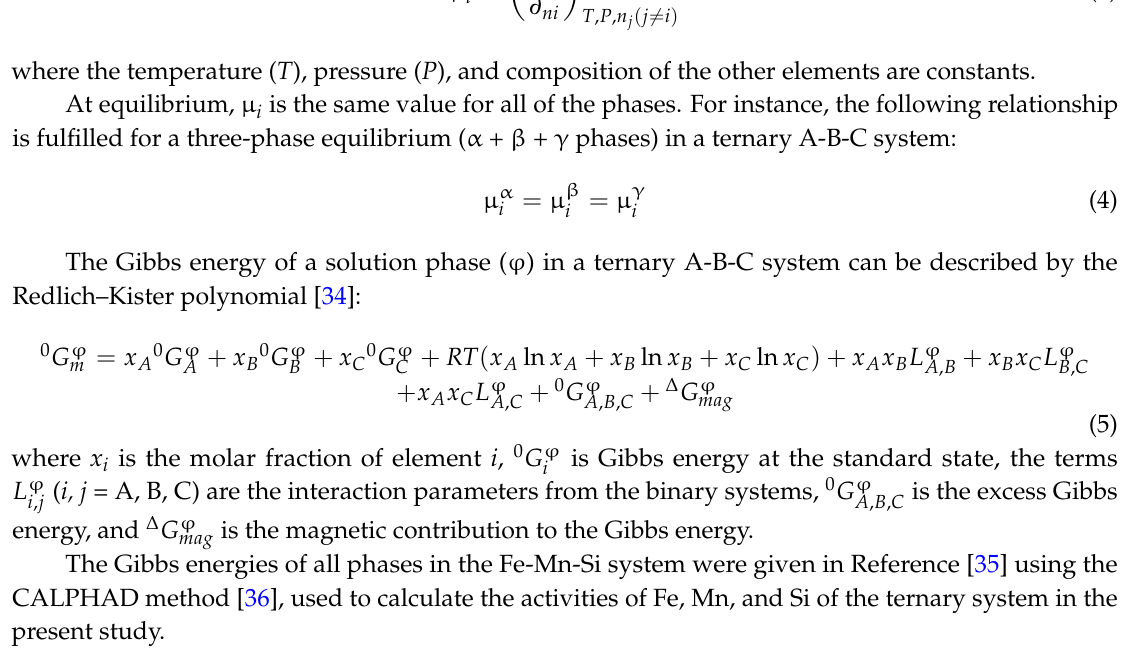
Bal. Figure 3. Morphologies of the cross-section of the MM Fe-28Mn-3Si alloys sintered at 1200 °C for 1 h.